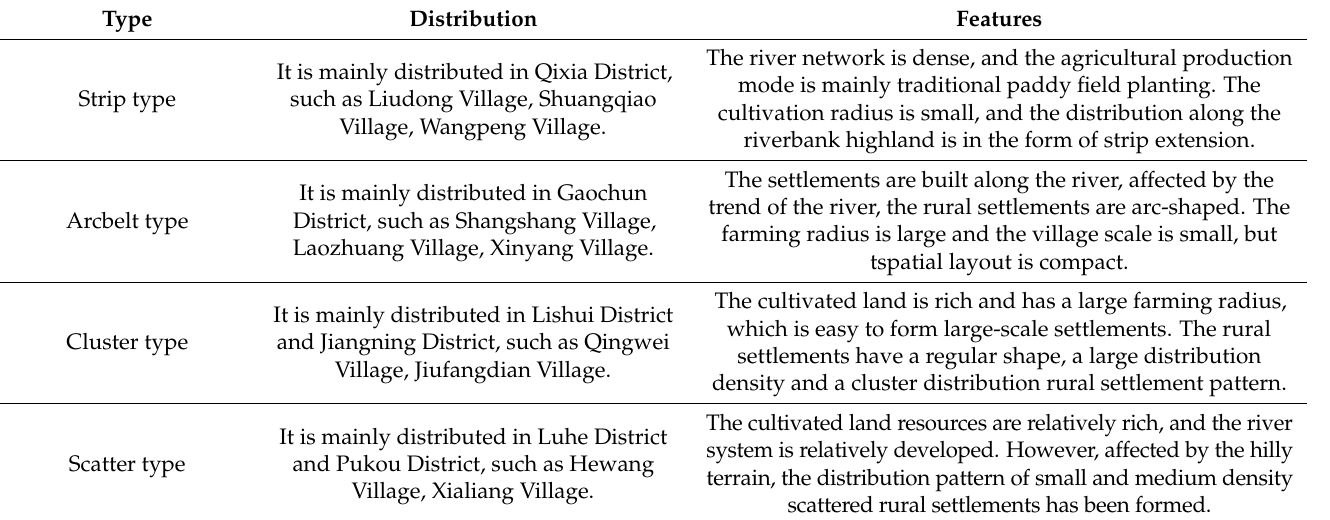
Table 2. The morphological types and basic characteristics of rural settlements in